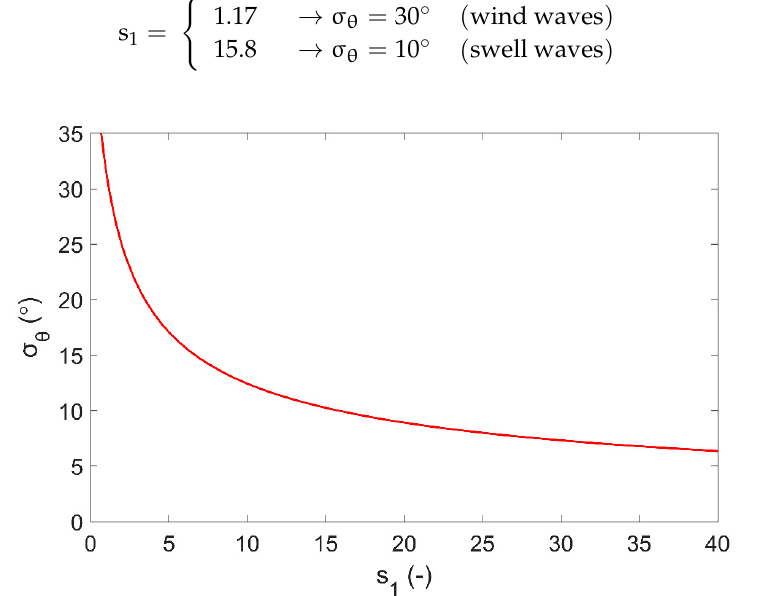
Figure 2. Relation between the directional spreading parameter, s (cid:2869) , and the spreading standard deviation, σ (cid:2968)